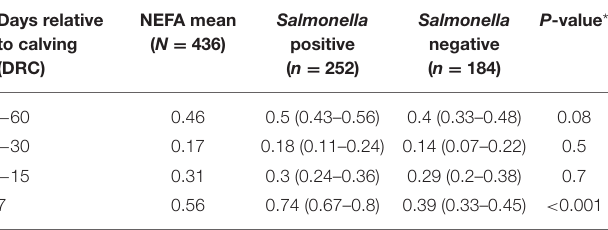
healthy animals and lymphatic tissues at abattoirs (31). In the TABLE 3 | Least square means (95% CI) for 436 non-esterified fatty acids (NEFA, mEq/L) measurements according to qPCR Salmonella status (positive or negative) during the periparturient period of 109 cows sampled at four time